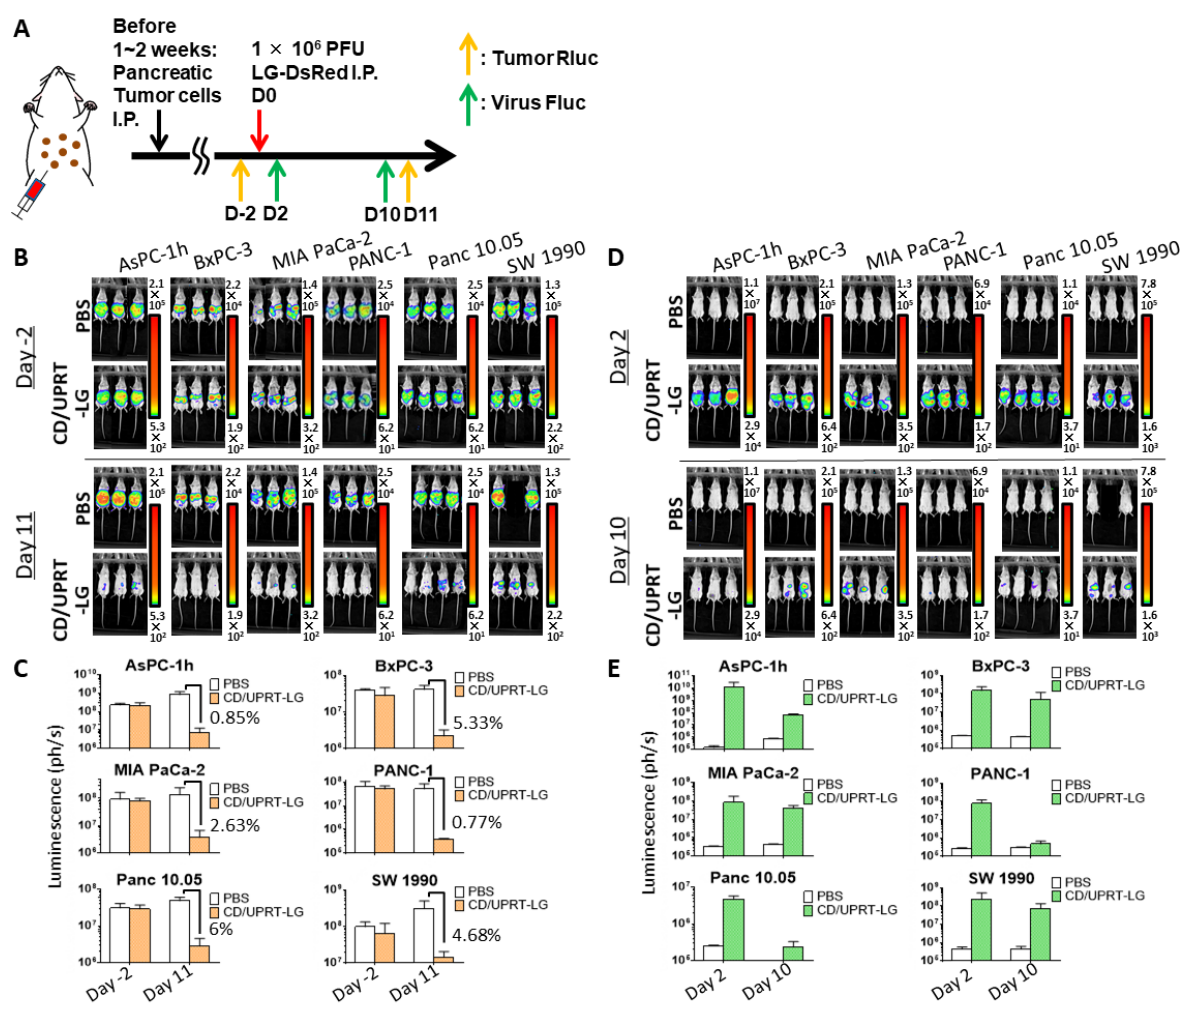
Figure 4. Mitogen-activated protein kinase-dependent recombinant vaccinia virus (MDRVV) (CD/UPRT-LG) efficiently eliminates peritoneally disseminated tumors and its replication decreases following tumor elimination in mouse tumors derived from human pancreatic ductal adenocarcinoma cell lines. ( A ) Schematic representation of the study design and timeline of tumor growth and viral distribution. Severe combined immunodeficiency mice with peritoneally disseminated six pancreatic cancer cell lines expressing Renilla luciferase (Rluc) were intraperitoneally injected with CD/UPRT-LG (1 × 10 6 PFU). ( B ) Tumor Rluc luminescence was detected on day 2 before and on day 11 after virus inoculation. One mouse bearing peritoneally disseminated SW 1990 xenografts died due to tumor burden 9 days after PBS treatment. ( C ) Quantification of tumor Rluc luminescence was determined from ( B ). ( D ) Viral firefly luciferase (Fluc) luminescence was determined on days 2 and 10 after virus inoculation. One mouse bearing peritoneally disseminated SW 1990 xenografts died due to tumor burden 9 days after PBS treatment. ( E ) Quantification of viral Fluc luminescence was determined from ( D ). The data are presented as the mean + SD (n =